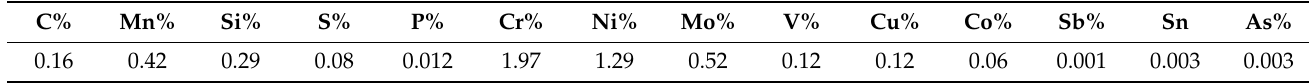
Table 1. Chemical composition of 15H2NMFA base metal